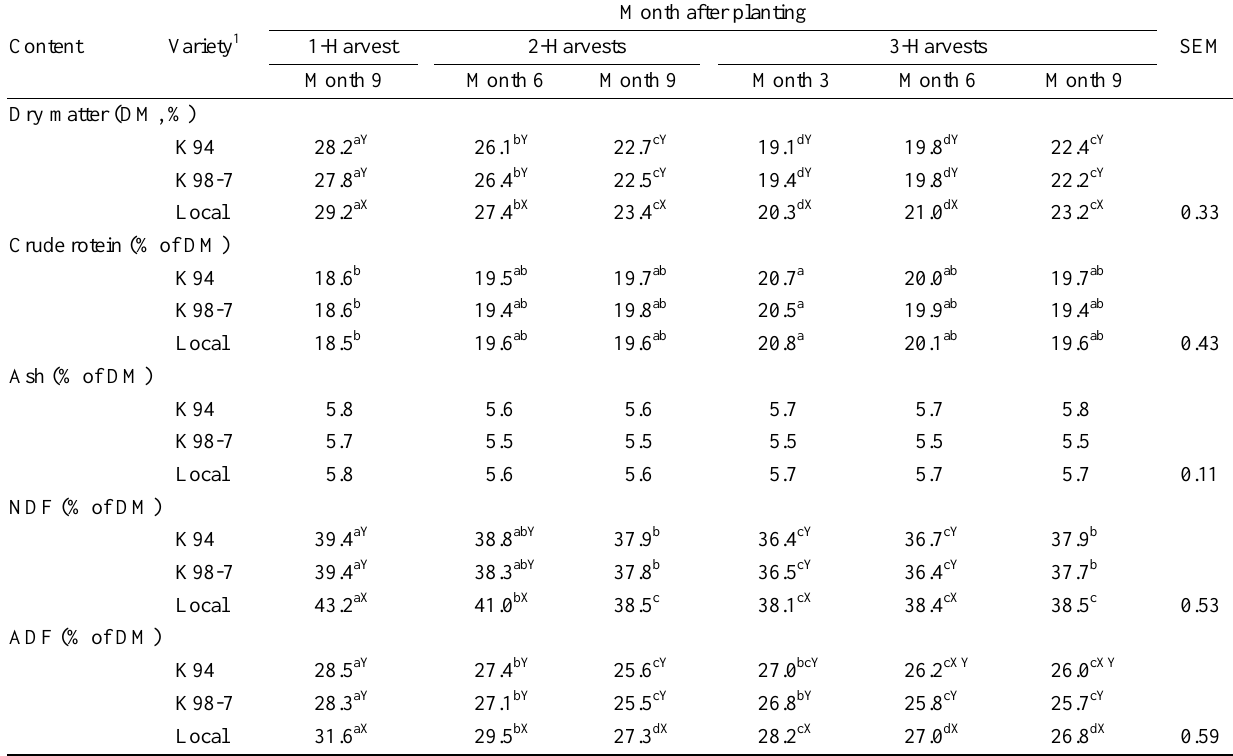
older leaves was higher in all varieties (Table 4). Older leaves also had a higher content of DM, NDF and ADF. The opposite trend was found for the HCN and CP contents, which were higher in the younger leaves.